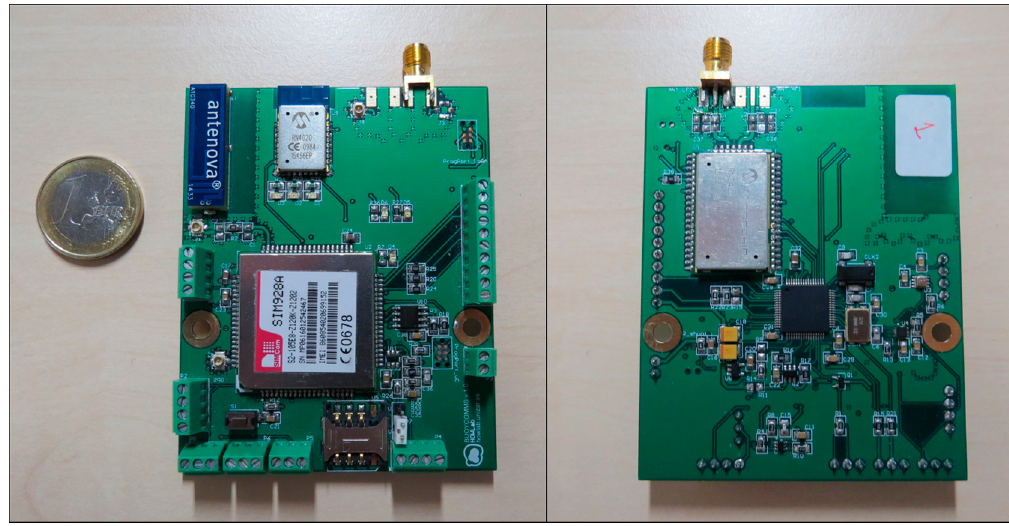
Figure 3. Design of the PCB for the environmental sensing buoys.